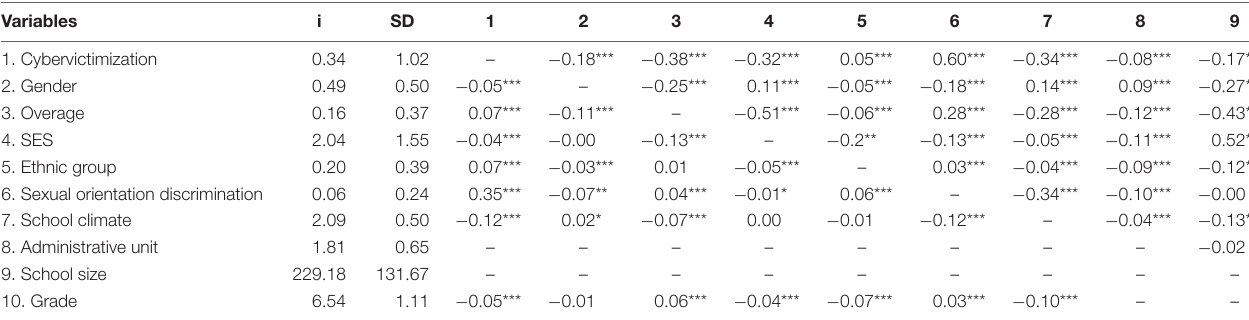
TABLE 2 | Descriptive statistics at the individual level and correlations at the individual and school level.